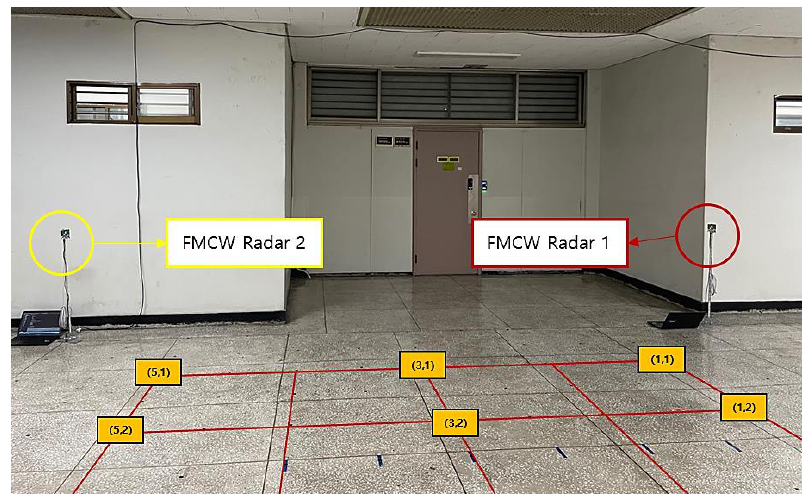
Figure 3. Schematic of experimental configuration with two FMCW radars.